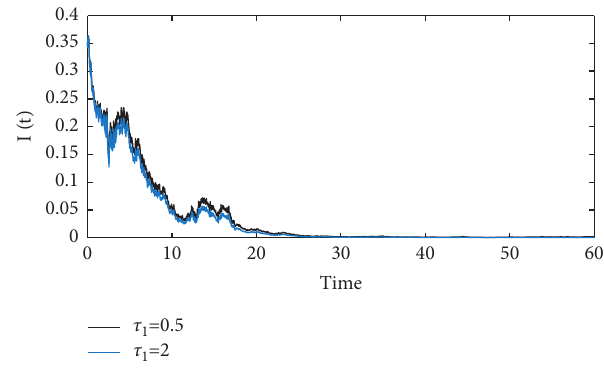
to the system (2). 1